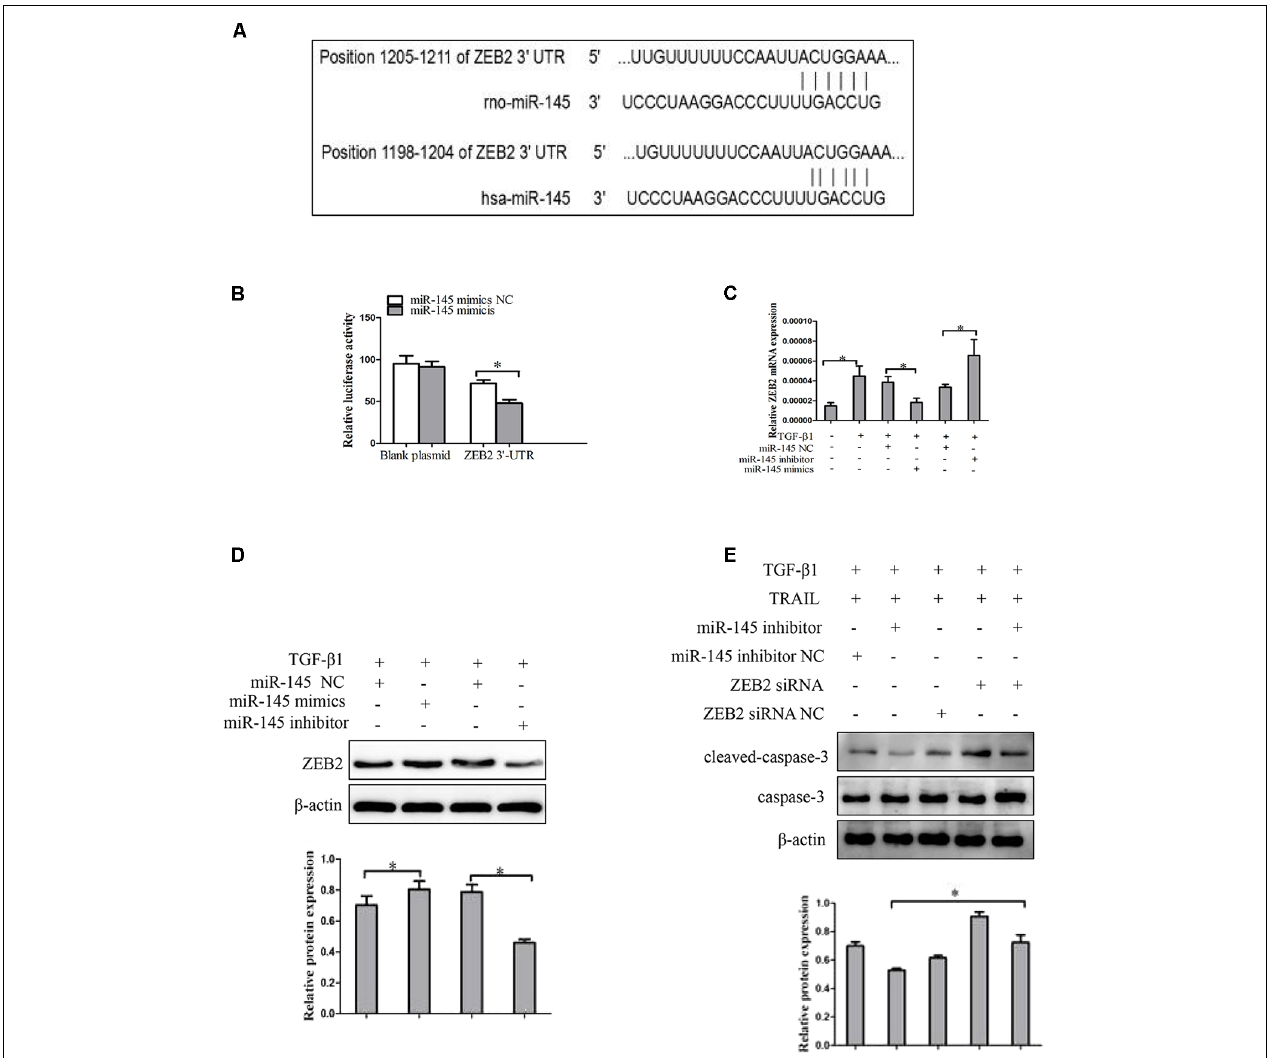
FIGURE 4 | ZEB2 is a direct target of miR-145 in activated HSCs cells. (A) The target genes of miR-145 were predicted by using bioinformatics tools (TargetScan, CLIP-Seq, miRDB, and miRanda). (B) A miR-145 mimic or negative control and a luciferase vector encoding the wild-type or mutant ZEB2 3 (cid:48) -UTR region were co-transfected into LX-2 cells, and the relative luciferase activity was measured. (C) Quantitative real-time PCR analysis for mRNA expression of ZEB2 after transfected with miR-145 mimics, miR-145 inhibitor, or miR-145 NC. (D) Western blot analysis for protein expression of ZEB2 after transfected with miR-145 mimics, miR-145 inhibitor, or miR-145 NC. (E) Protein level of the cleaved of caspase-3 was determined by Western blot analysis in activated LX-2 cells co-transfected with miR-145 inhibitor and ZEB2-siRNA, The assays were performed at least three times with similar results. Data are shown as the mean ± SD ( n = 3) of one representative experiment. ∗ p < 0.05 versus normal